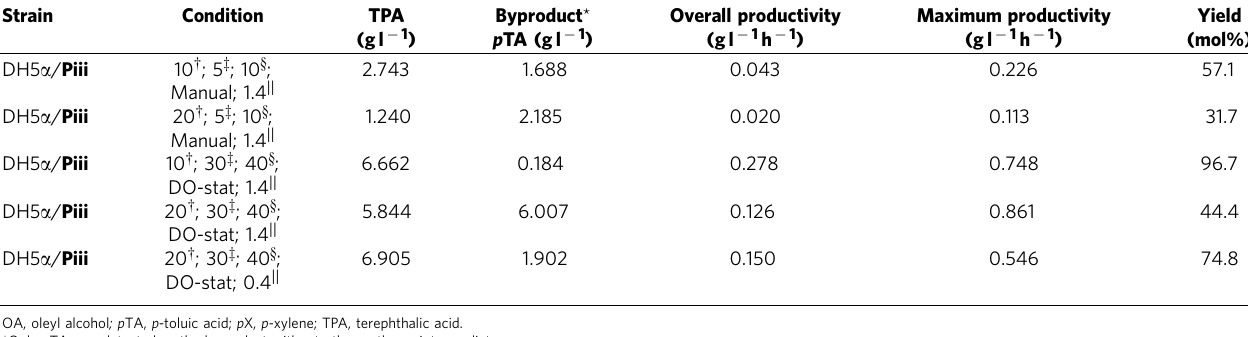
Table 1 | Two-phase fermentation performances of the engineered E. coli strains under various conditions.